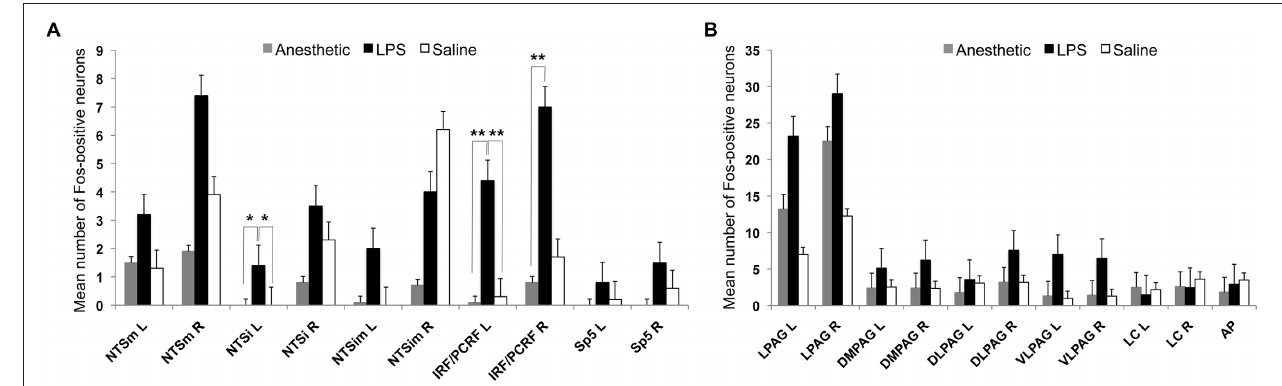
FIGURE 3 | The bar graphs show the mean number of Fos-positive neurons in the examined brainstem nuclei in the LPS-, vehicle-treated and anesthetic controls. (A) Double asterisks ( ∗∗ ) mark significant FLI in the IRF/PCRF nucleus, while single asterisk ( ∗ ) marks a trend in FLI increase in the NTSi nucleus in LPS-treated animals compared to vehicle-treated animals and anesthetic controls. (B) No statistically significant differences between